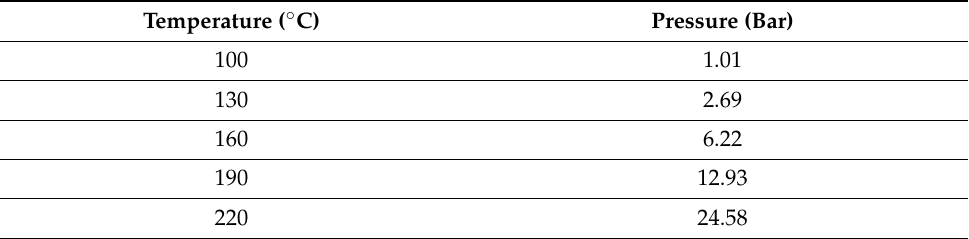
Table 1. Pressure recorded at each thermal bone-processing temperature within the stainless- steel